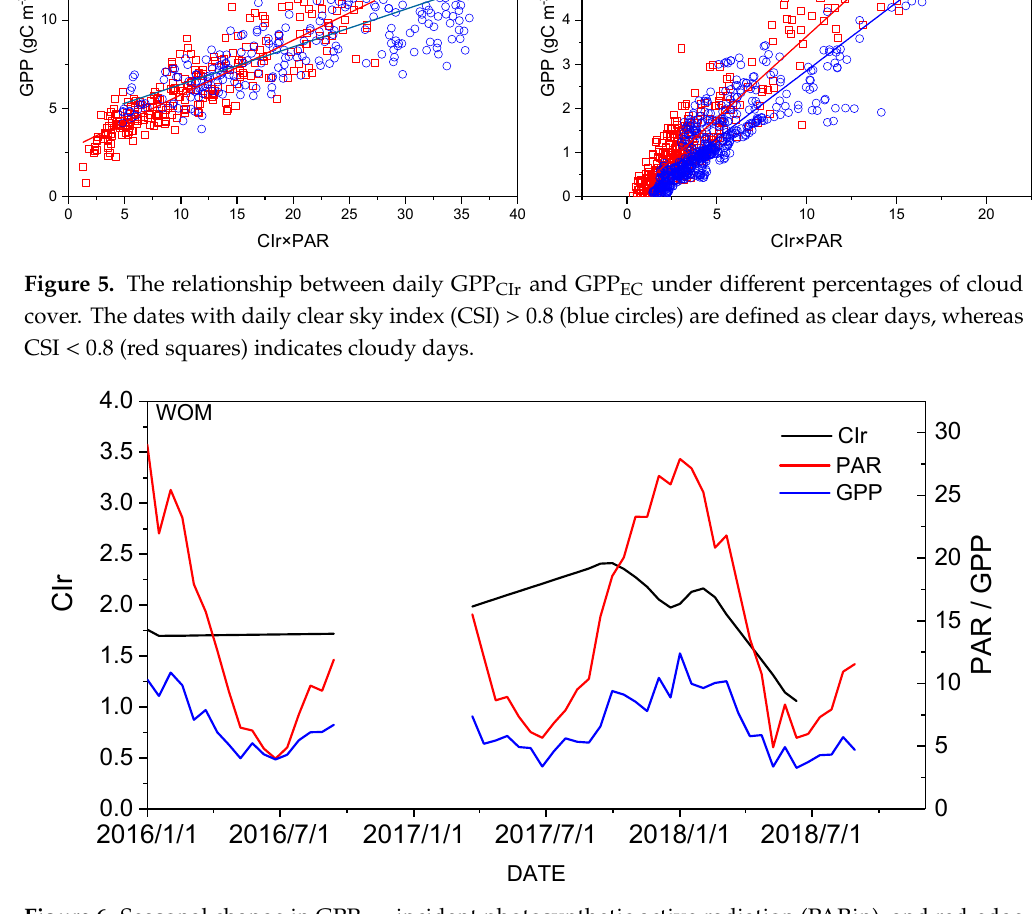
Figure 6. Seasonal change in GPP EC , incident photosynthetic active radiation (PARin), and red-edge chlorophyll index (CIr) during the research period (PAR in MJ ∙ day − 1 , GPP in gC ∙ m − 2 ∙ day − 1 ).